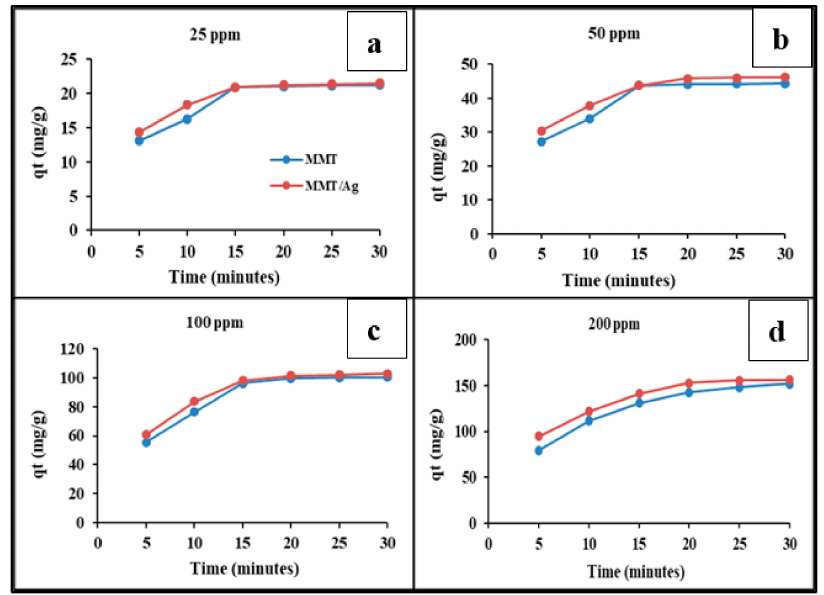
Figure 11. Effect of the contact time on adsorption capacity of raw MMT clay and MMT/Ag nanocomposite ( a ) 25 ppm, ( b ) 50 ppm ( c ) 100 ppm and ( d ) 200 ppm of